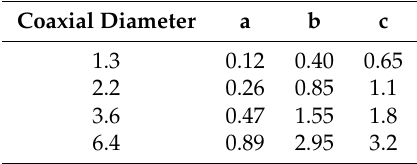
Table 1. Coaxial probe dimensions, expressed in millimeters. Variables a , b and c represent the radii of the center conductor, coaxial dielectric and outer conductor, respectively (Figure